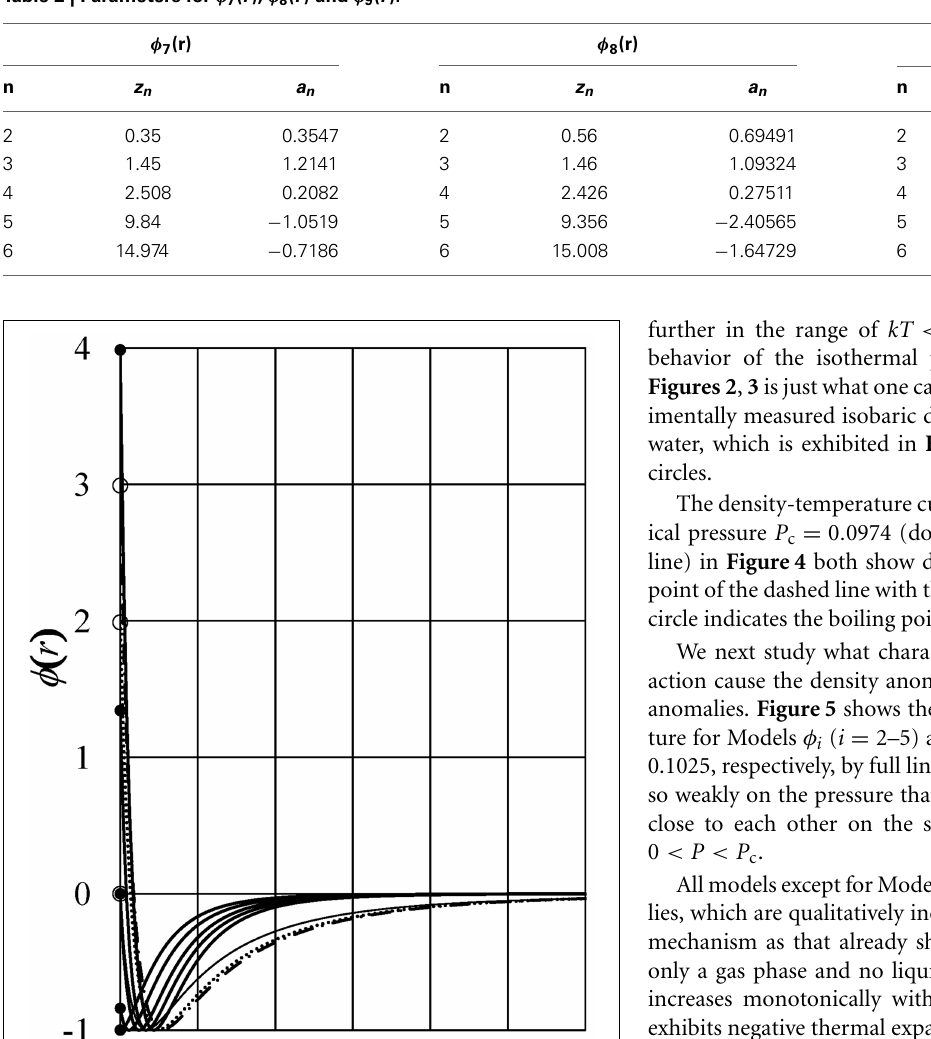
Table 2 | Parameters for φ 7 ( r ), φ 8 ( r ) and φ 9 ( r ).